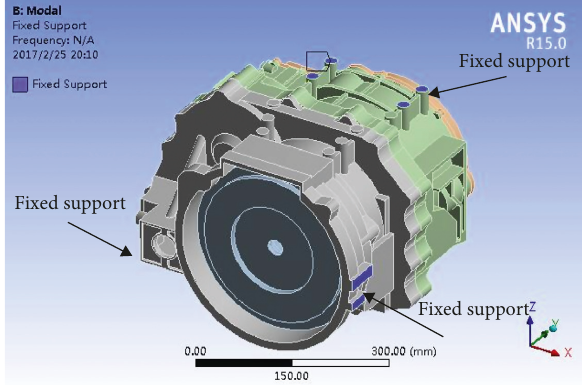
Figure 6: Fixed support of the